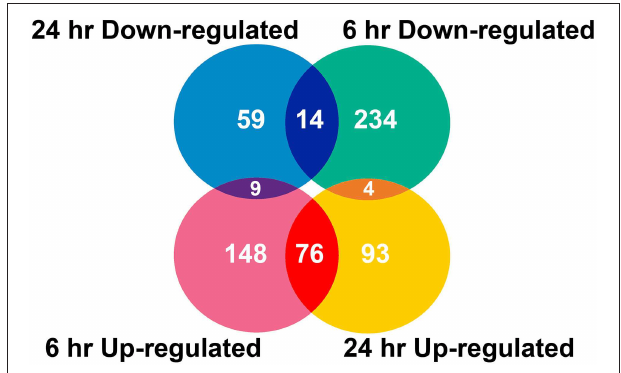
FIGURE 1 | Venn diagram of rice genes (probe sets) responded to